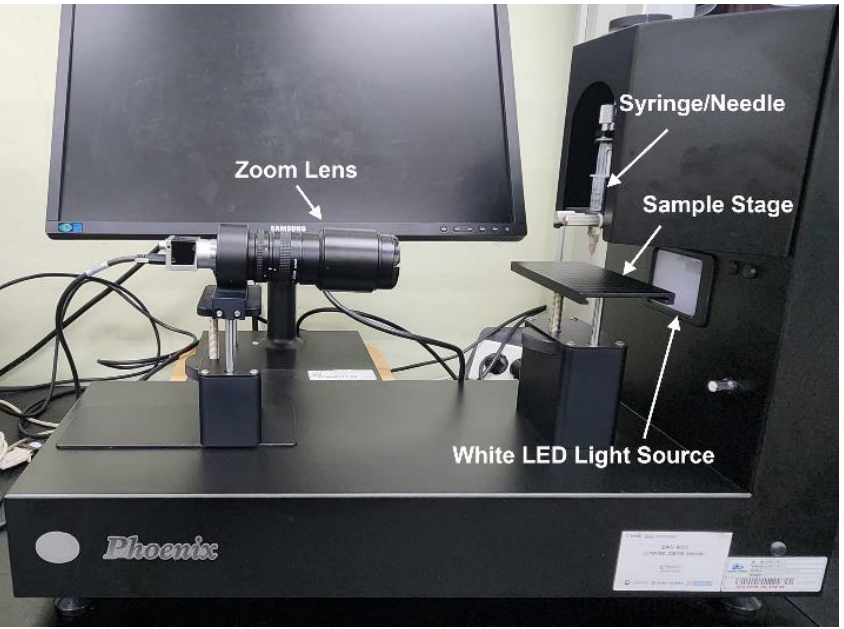
Figure 2. Contact angle analyzer, SEO — Phoenix 10 from S.E.O. Co. Ltd. (Seoul, Korea). To perform the surface treatment, the PMMA sheets were placed in a closed box and exposed to UV light. The intensity of UV irradiation at a wavelength of 253.7 nm was measured to be 5 mW/cm 2 . To study the relation between UV exposure dose and surface wettability, the samples were exposed for 5 min, 10 min, 20 min, and 30 min under a stabilized UV lamp, which are equivalent with the doses of 1.5 J/cm 2 , 3 J/cm 2 , 6 J/cm 2 , and 9 J/cm 2 , respectively. Figure 3 shows the schematic procedures of the experiment to collect data on the wettability of a PMMA surface for different surface treatment conditions.